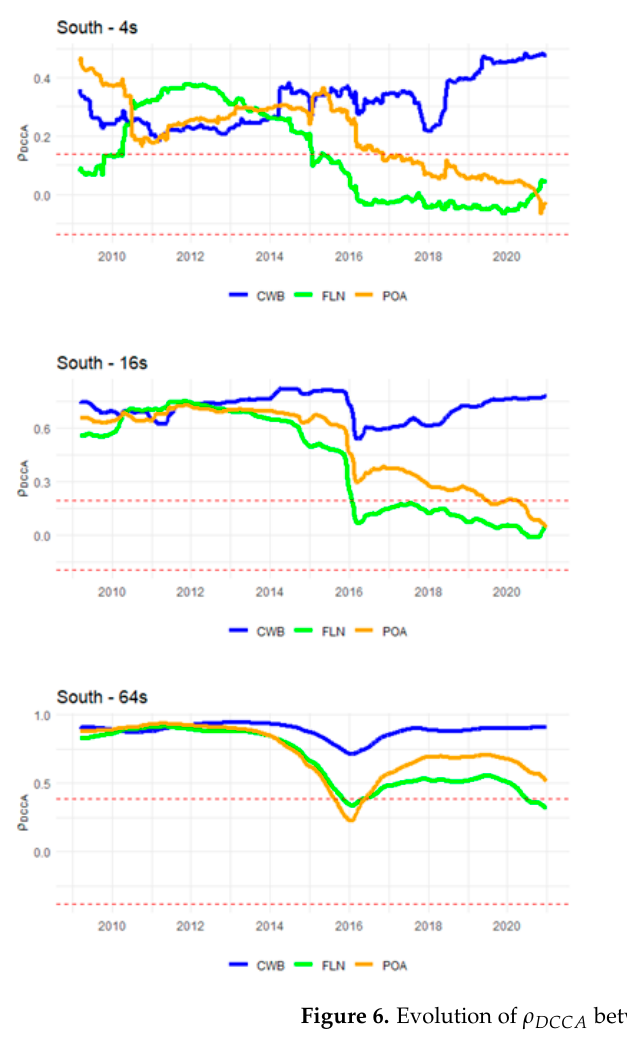
Figure 6. Evolution of ρ DCCA between the relative prices of S ã o Paulo and other capitals in the South Region, with time scales of 4, 8, 16, 32 and 64 weeks, and moving window w = 250. Shaded lines are the upper and lower confidence intervals, in the sense that values between these are not statistically significant, according to the critical values of [66].